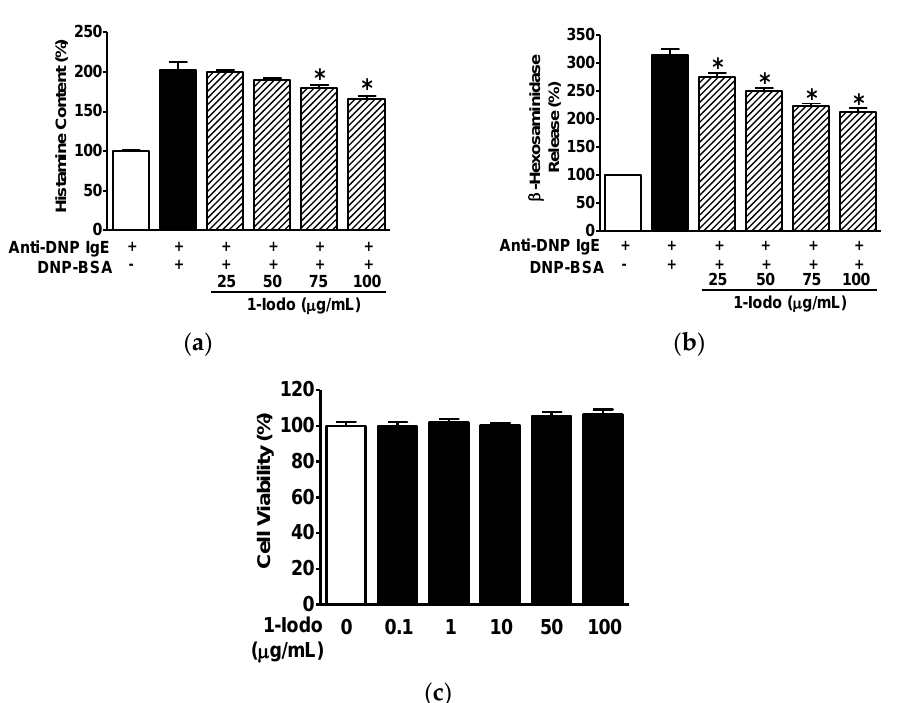
Figure 2. Effects of 1-iodohexadecane on immunoglobulin E-antigen complex-induced histamine and β -hexosaminidase release from RBL-2H3 cells. ( a , b ) Histamine and β -hexosaminidase releases from RBL-2H3 mast cells. After treatment for 48 h in the presence or absence of 1-iodohexadecane (1-Iodo; 25 –100 μg/mL), cells were incubated with anti -dinitrophenyl-immunoglobulin E (anti-DNP-IgE; 200 ng/mL) for 10 h and then stimulated with 2,4-dinitrophenyl labeled-BSA (DNP-BSA: 10 ng/mL) for 1 h. Culture media were collected and centrifuged, and the levels of histamine ( a ; n = 3) and β -hexosaminidase ( b ; n = 3) in the supernatant (conditioned media) were measured using an enzyme immunoassay. The response in cells treated with anti-DNP-IgE alone was considered 100%. The results are represented as means ± SEMs. * p < 0.05 vs. DNP-BSA stimulated cells in the presence of anti-DNP-IgE alone. ( c ) Cell viability in RBL-2H3 cells exposed to 1-Iodo. Cells were treated with 1-Iodo (0.1 – 100 µg/mL) for 48 h. Cell viabilities were measured using an EZ-CyTox kit. The response levels are expressed as percentages of levels in untreated cells ( n = 5). Results are expressed as means ± SEMs. * p < 0.05 vs. untreated cells.